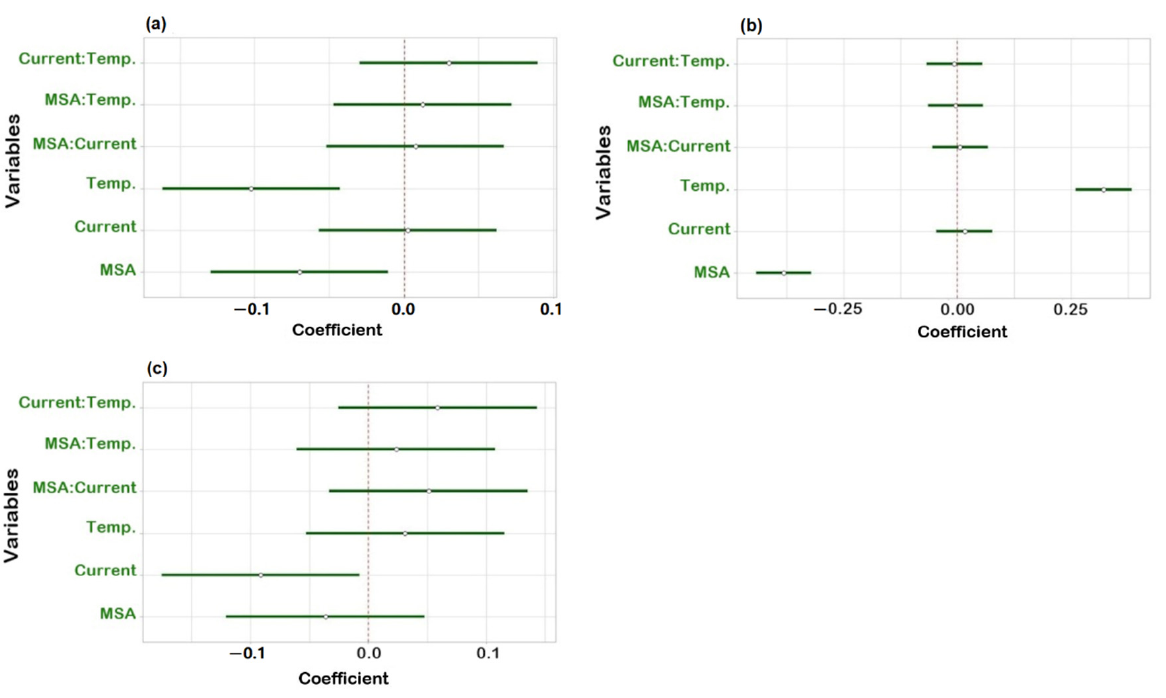
Figure 4. Regression coefficient plots obtained from the robustness study for ( a ) resolution between Na + and K + ; ( b ) resolution between K + and Mg 2+ ; ( c ) resolution between Mg 2+ and Ca 2+ .